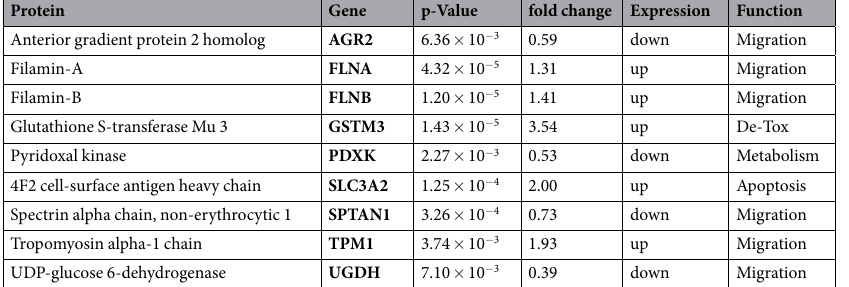
Table 1. Targets with significant difference between both groups – M1 and M2 and M3 vs MCF7 and